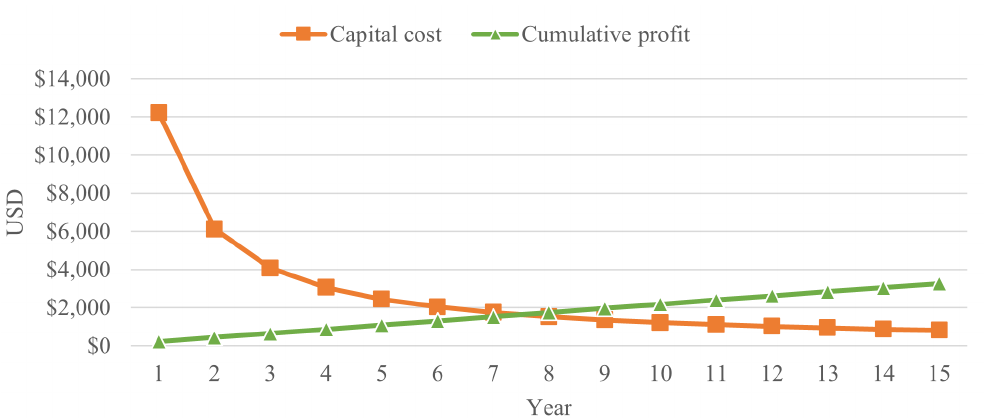
Figure 11. Return of Investment analysis for CPVT-VMD